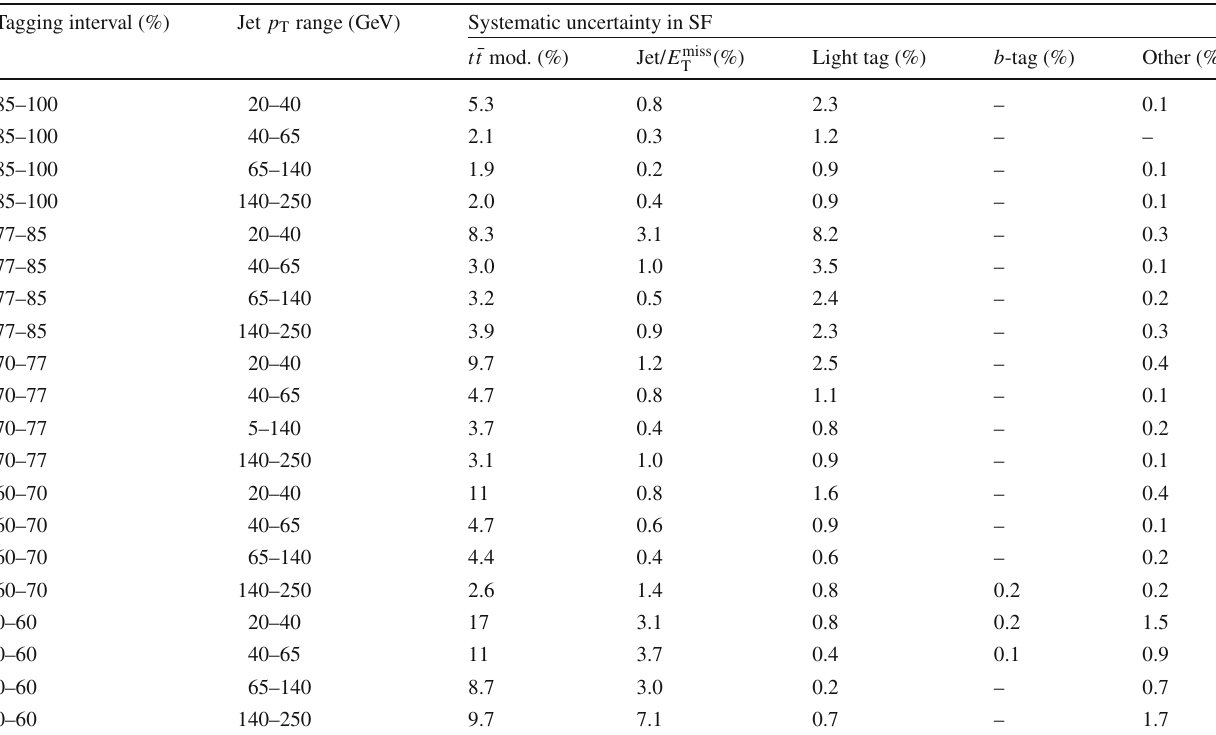
, the light-flavour jet scale factor, the b -jet scale factor, and all other sources T